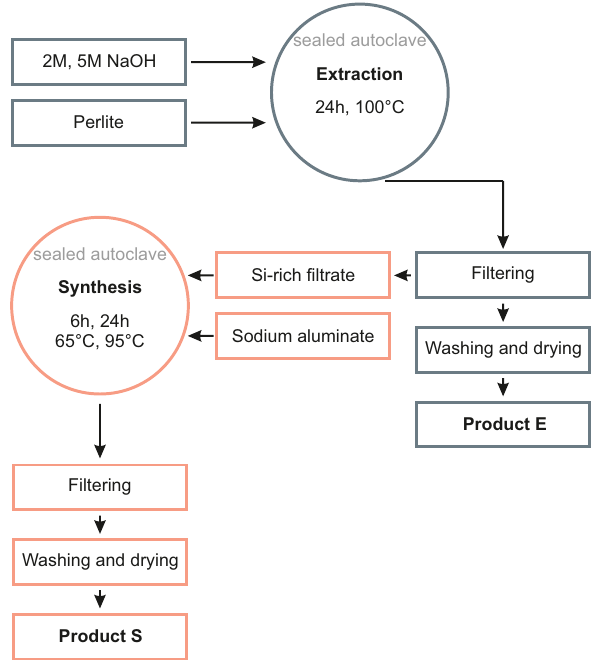
Figure 3. Flow chart showing the two-step synthesis of zeolites via an alkali-hydrothermal method. Target product E: GIS or SOD. Target product S: